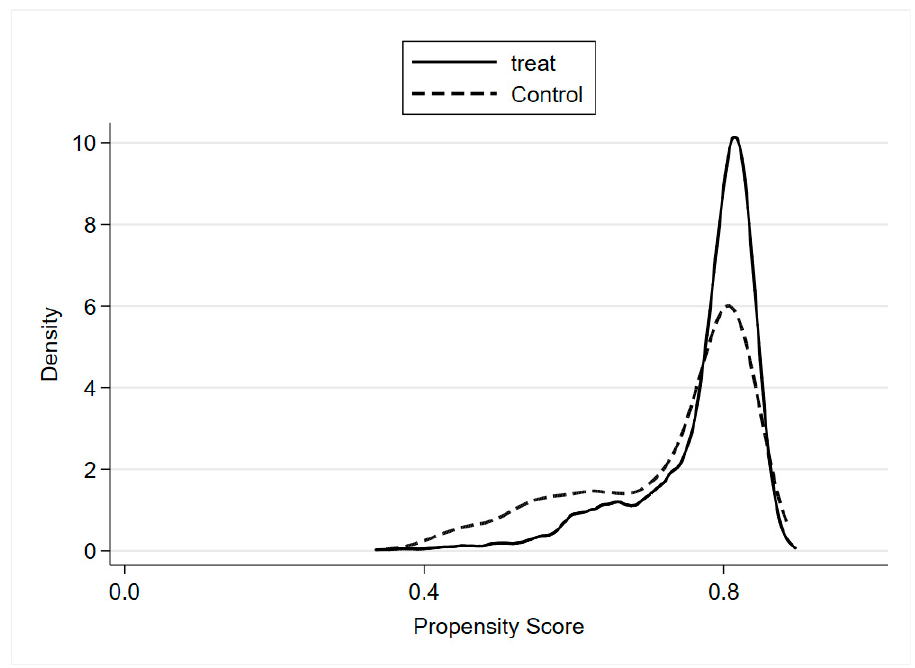
Figure 4. Density distribution of the propensity score (after matching).